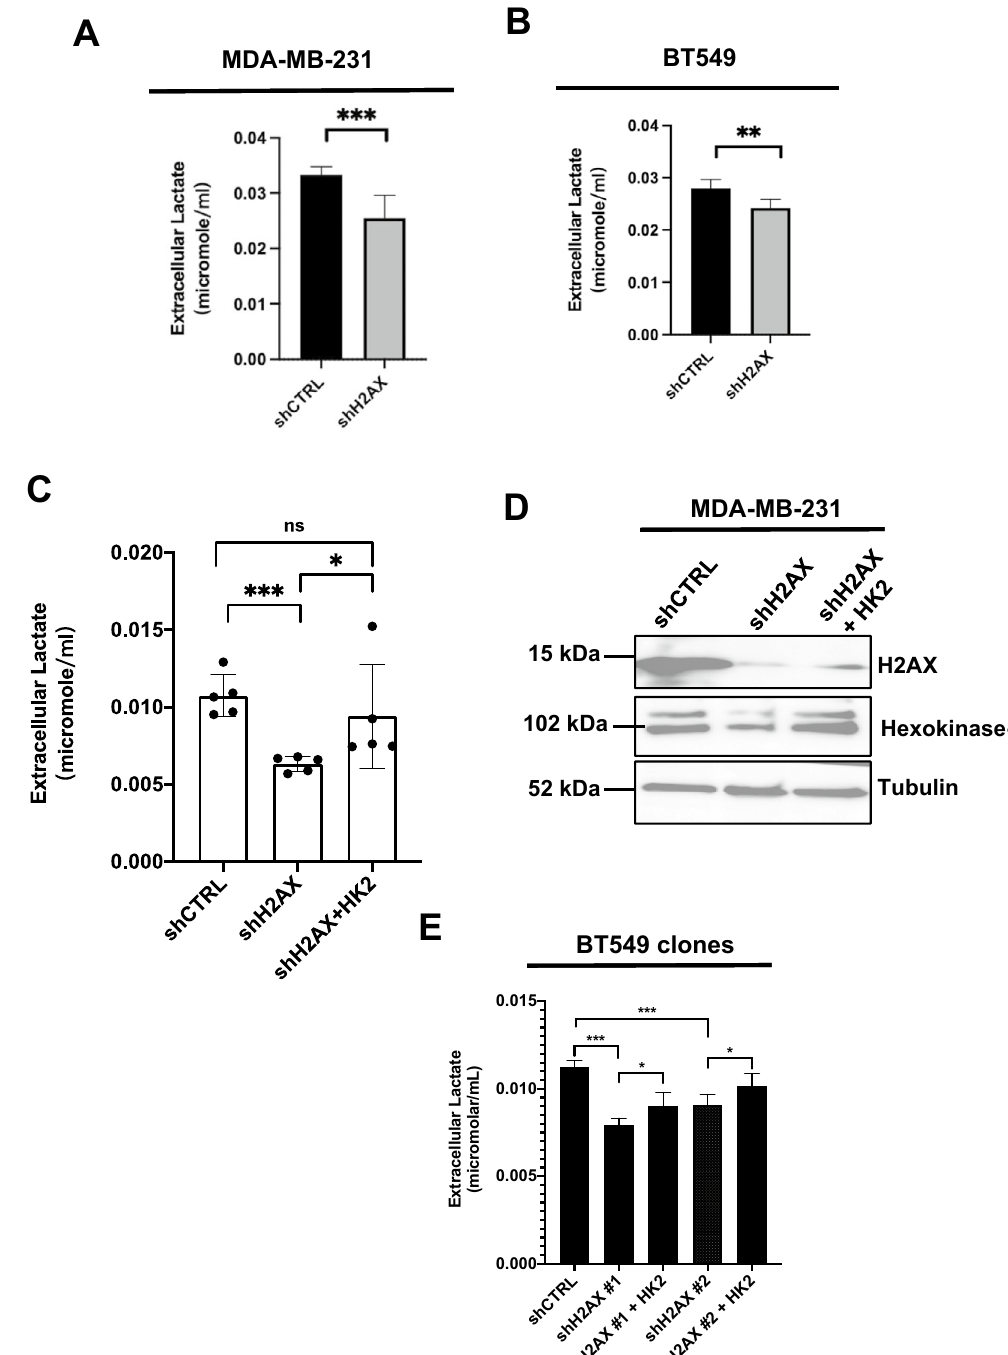
Figure 3. H2AX silencing leads to reduced glycolysis in invasive breast cancer cells. ( A , B ) H2AX silencing resulted in a 20% diminution in glycolysis level in both MDA-MB-231 ( A ) and BT549 cells ( B ). Level of glycolysis was detected by measurement of extracellular lactate production as described in “Methods” section. Error bars represent S.E.M. ( n = 9). ( C ) Extracellular lactate level in MDA-MB-231 control cells (shCTRL), H2AX-deficient cells (shH2AX), and H2AX-deficient cells in which HK2 expression was reintroduced (shH2AX + HK2). ( D ) Cells described in ( C ) were subjected to immunoblot for the detection of protein levels for H2AX, HK2, and tubulin. ( E ) BT-549 cells were infected with either scrambled short hairpin RNA, or with short hairpin RNA against H2AFX (shH2AX), and cells were selected in the presence of puromycin to establish stable clones (shH2AX #1, and shH2AX #2). These control and H2AX-deficient cells were transfected with either control vector (shCTRL) or with vector expressing HK2 (shH2AX + HK2), and the resulting cells were used for quantification of extracellular lactate level. Statistical significance was determined by a two-tailed, unpaired Student’s t -test. Error bars represent S.E.M. ( n = 6). *p value < 0.05, ***p value ≤ 0.0001, ns: non-